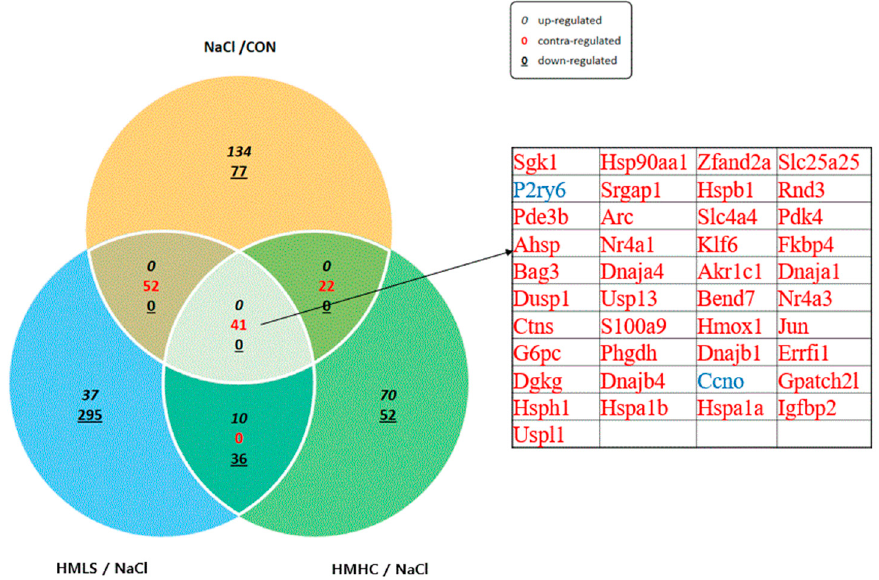
Figure 6. Examination of differentially expressed genes in kidney tissues. CON, normal diet + distilled water; NaCl, 8% NaCl diet + distilled water; HMLS, 8% NaCl diet + high magnesium low sodium water; HMHC, 8% NaCl diet + high magnesium high calcium water. Differentially expressed genes screened from the kidneys of rats. Genes that satisfied the criteria of fold change ≥ 2, normalized data (log2) = 0, and p -value ≤ 0.05 were selected for CON vs. NaCl, HMLS vs. NaCl, and HMHC vs.